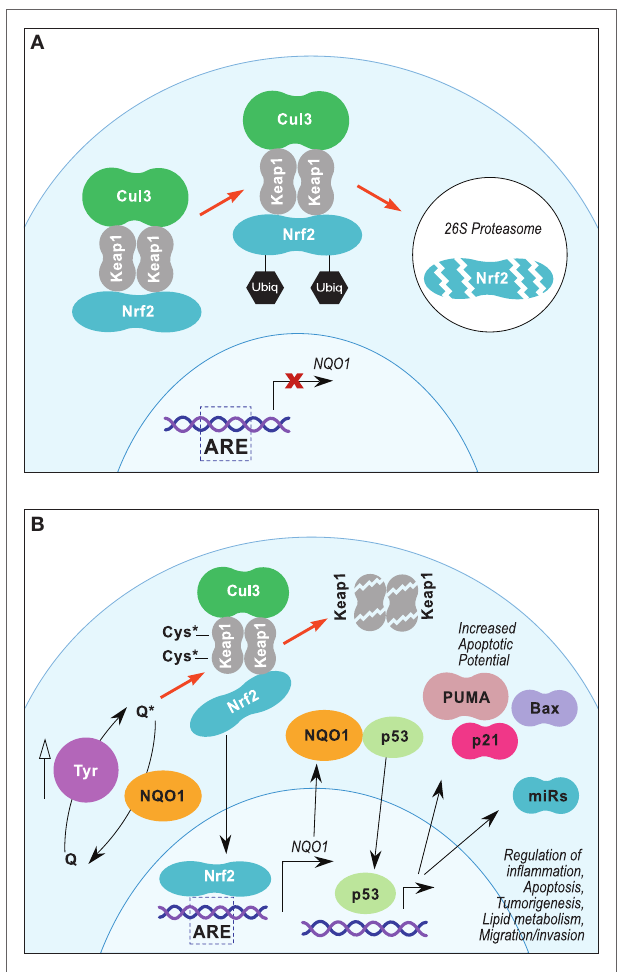
FigURe 2 | (A,b) Proposed Nrf2/ARE pathway leading to NQO1-mediated p53 stabilization in melanoma. (A) In steady-state conditions, Nrf2 transcriptional activity is suppressed by Keap1, which sequesters Nrf2 in the cytosol and facilitates Cul3-dependent ubiquitinylation and 26S proteasomal degradation. (b) Electrophilic stress at key cysteine residues of Keap1 leads to disassociation of Keap1/NRF2–DLG interface, which inhibits Cul3- dependent ubiquitinylation and promotes Keap1 degradation. Degradation of Keap1 protein allows accumulation of Nrf2 and translocation into the nucleus, which promotes expression of NQO1 and other genes under the control of AREs. Stabilization of p53 by NQO1 may potentiate expression of proapoptotic proteins and